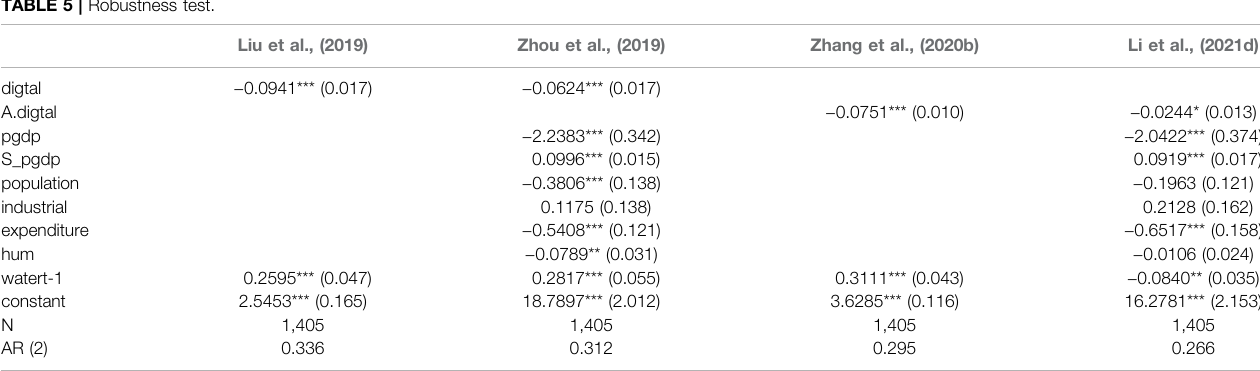
TABLE 5 | Robustness